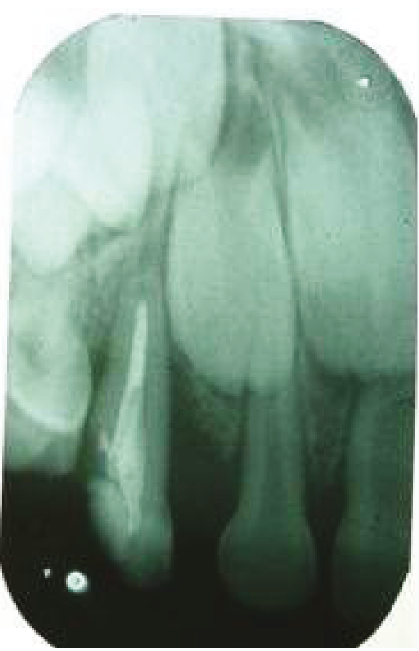
Figure 6: Radiograph taken at 12th-month follow-up.